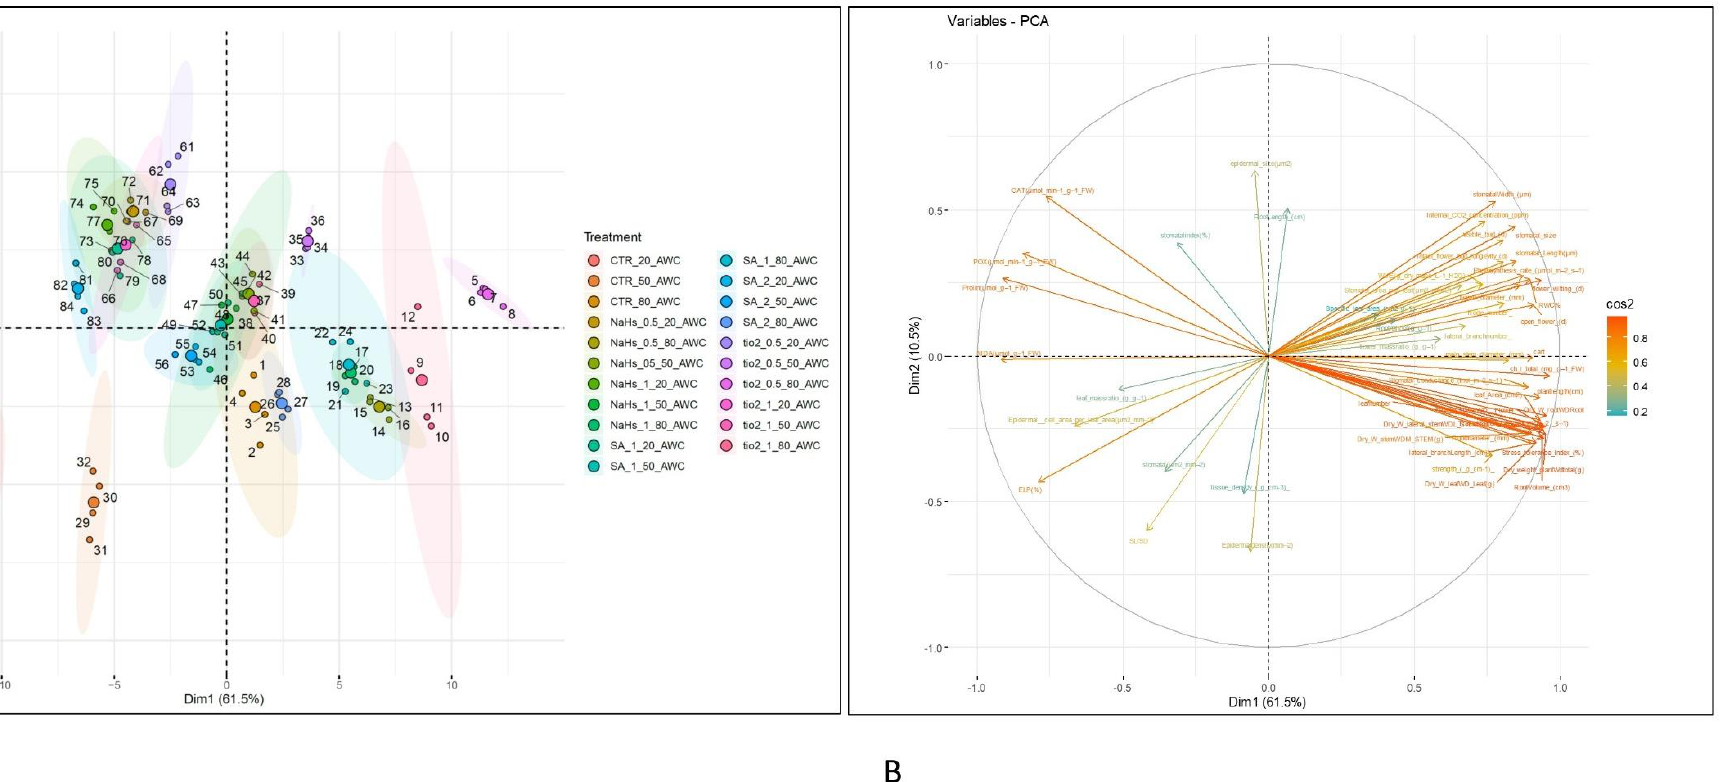
Figure 2. ( A ) Principal coordinate analysis across watering levels (80, 50 and 20% available water content), and spray treatments (titanium dioxide nanoparticles (TiO 2 NPs; 0, 0.5 and 1 mM), sodium hydrosulfide (NaSH; 0.5 and 1 mM), or salicylic acid (SA; 1 and 2 mM)) in periwinkle ‘Pacifica XP Really Red’. Larger dots indicate mean values calculated from four discrete biological replications. ( B ) The contribution of each trait in the two dimensions is indicated by a gradient scale and color intensity (scale). Vectors near the plot center have lower cos2 values. Narrow angles among variables indicate affinity and wide angles a negative correlation.